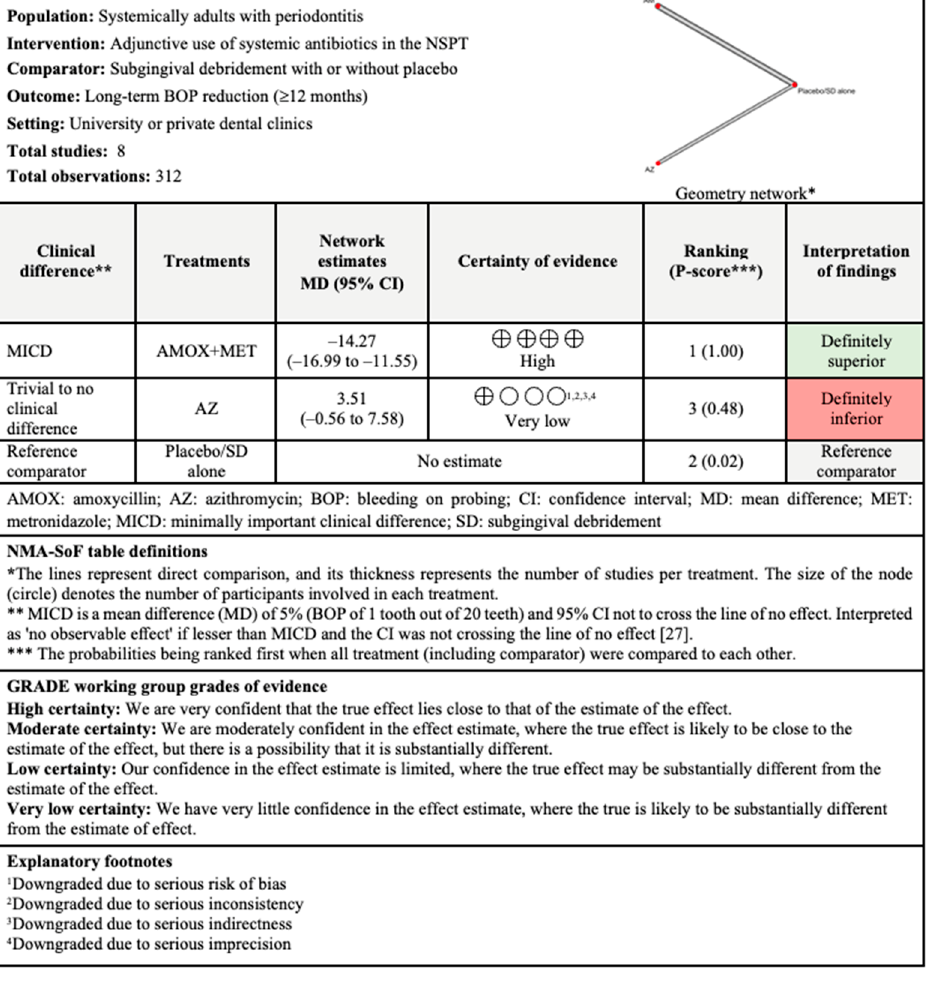
Figure 14. Summary of findings for long-term BOP reduction following the use of systemic antibiotics adjunctive to subgingival debridement.